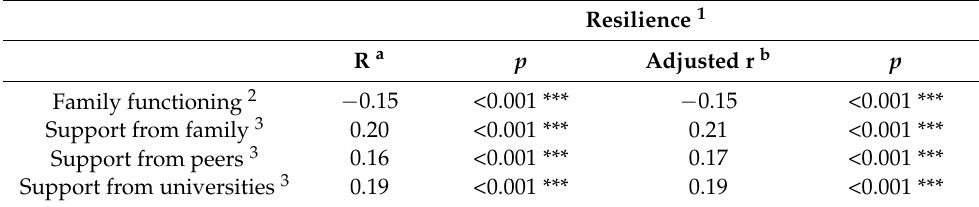
Table 4. Associations of resilience with family functioning and support